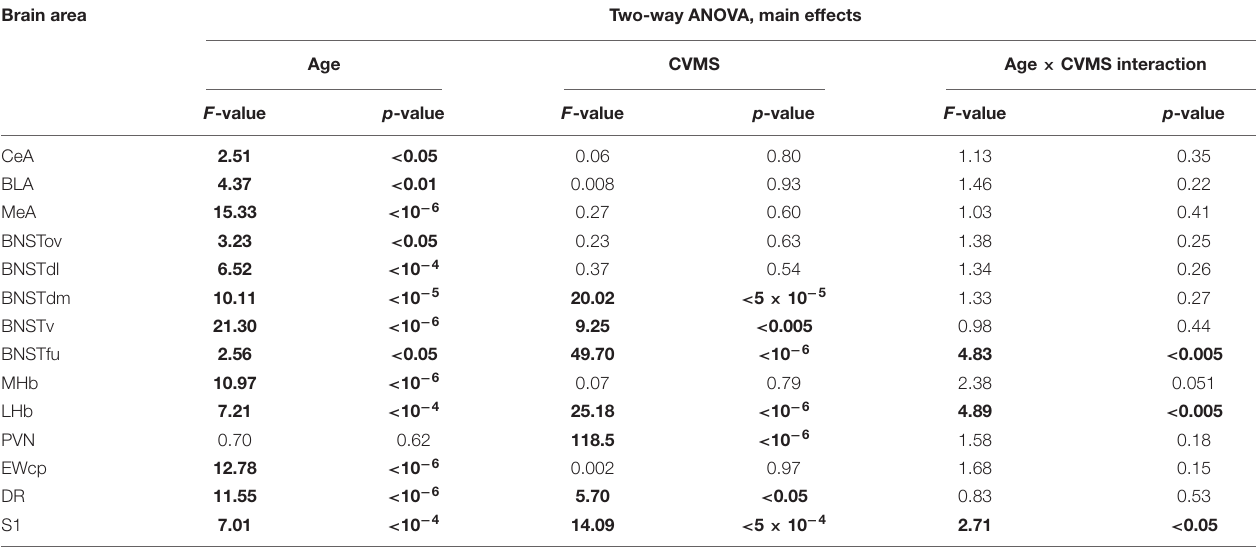
TABLE 7 | Summary of the statistical results of the two-way ANOVAs in chronic variable mild stress (CVMS) model. Brain